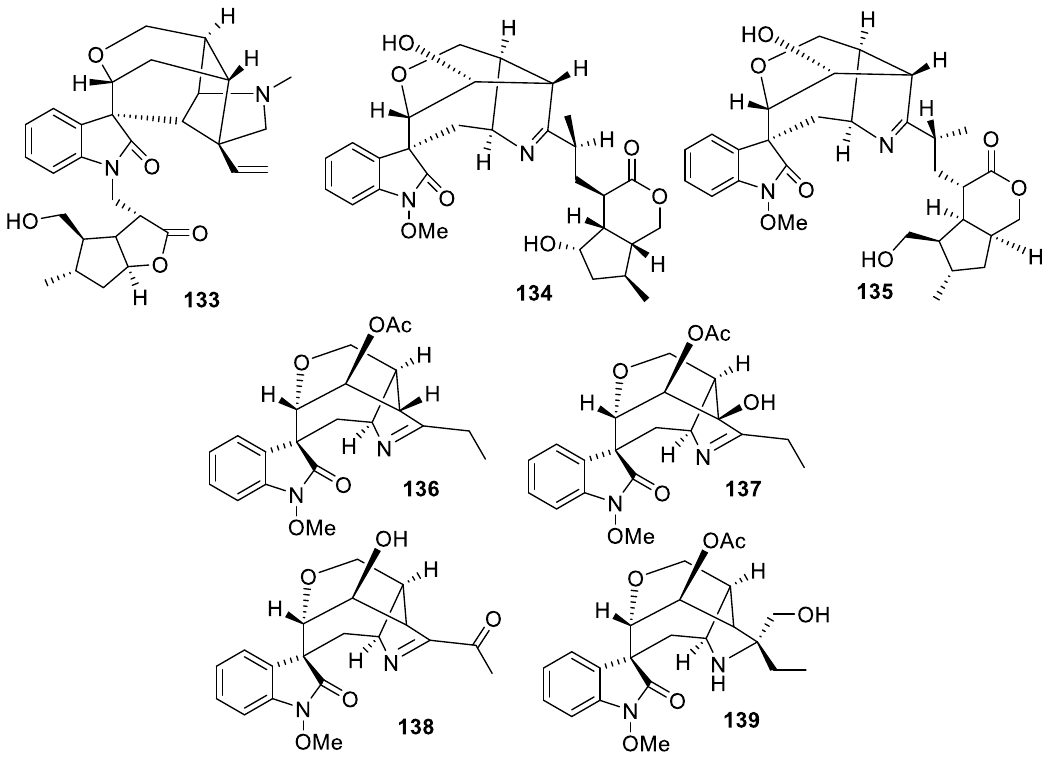
Figure 65. Structures of gelsenium alkaloids possessing a [4.6.0] spirocyclic system.